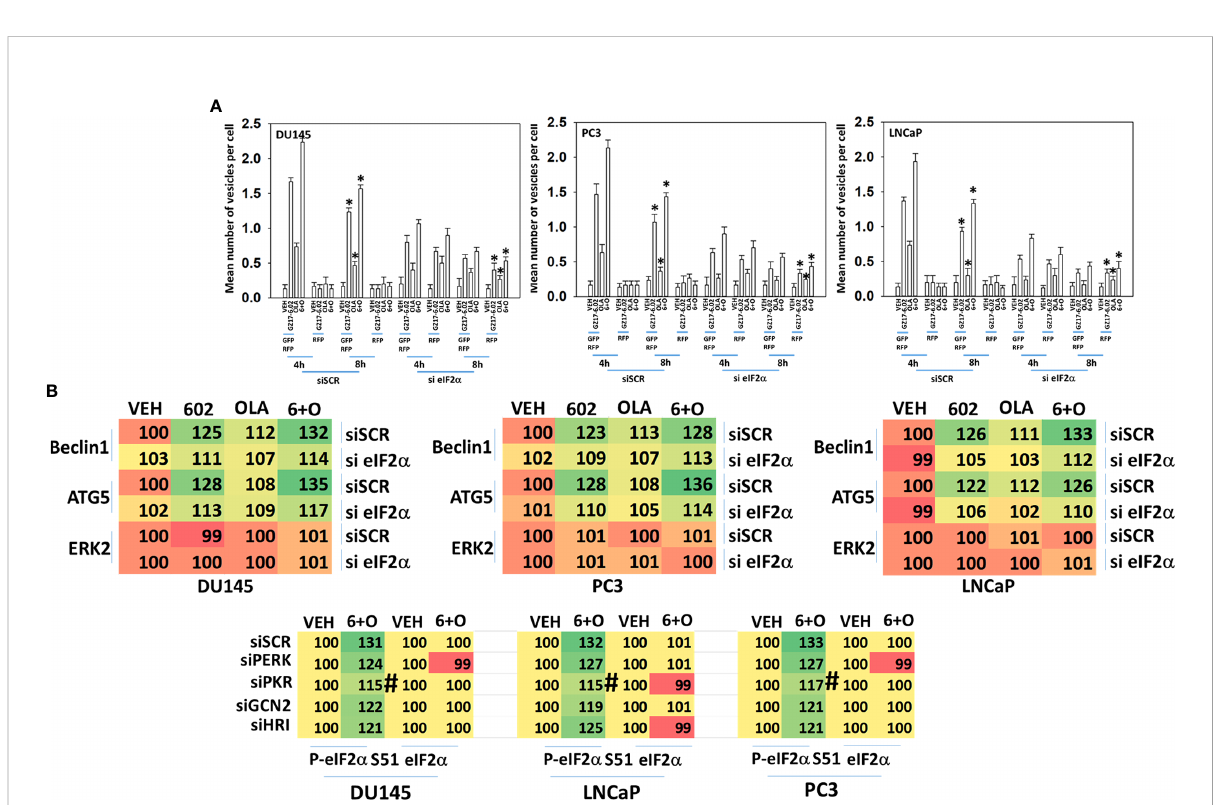
FIGURE 5 ER stress signaling is required for autophagosome formation and the increased expression of Beclin1 and ATG5. (A) Cells were transfected with a plasmid to express LC3-GFP-RFP and in parallel transfected with a scrambled siRNA or with an siRNA to knock down the expression of eIF2 a . Twenty-four h later, cells were treated with vehicle control, GZ17-6.02 (2 m M), olaparib (50 nM) or the drugs in combination for 4h and 8h. At each time point, the mean number of GFP+RFP+ and only RFP+ vesicles per cell were determined (n = 3 +/-SD). *p < 0.05 less than corresponding value in siSCR transfected cells. (B) Cells were transfected with a scrambled siRNA or with an siRNA to knock down the expression of eIF2 a . Twenty-four h later, cells were treated with vehicle control, GZ17-6.02 (2 m M), olaparib (50 nM) or the drugs in combination for 6h. Cells were fi xed in situ, permeabilized, stained with the indicated validated primary antibodies and imaged with secondary antibodies carrying red- and green- fl uorescent tags. The staining intensity of at least 100 cells per well/condition is determined in three separate studies. The data presented the normalized amount of fl uorescence set at 100% comparing intensity values for vehicle control (n = 3 +/-SD). # p < 0.05 greater than vehicle control; *p < 0.05 less than vehicle control; † p < 0.05 less than corresponding value in siSCR